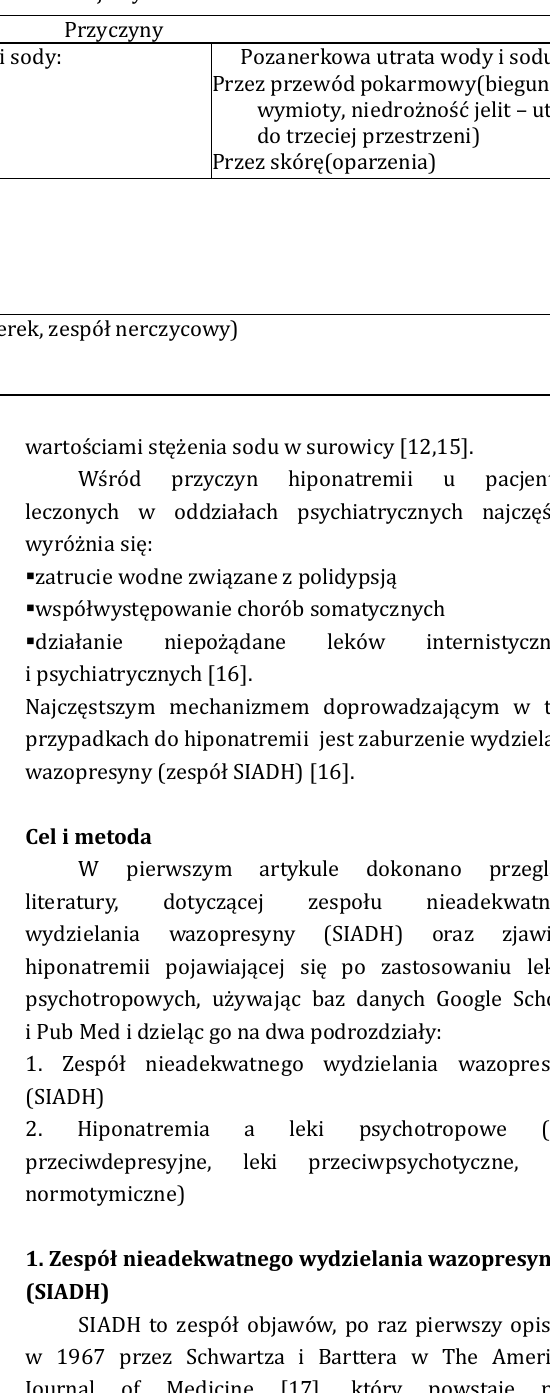
Tabela 3. Podział hiponatremii w zależności od objętości płynów